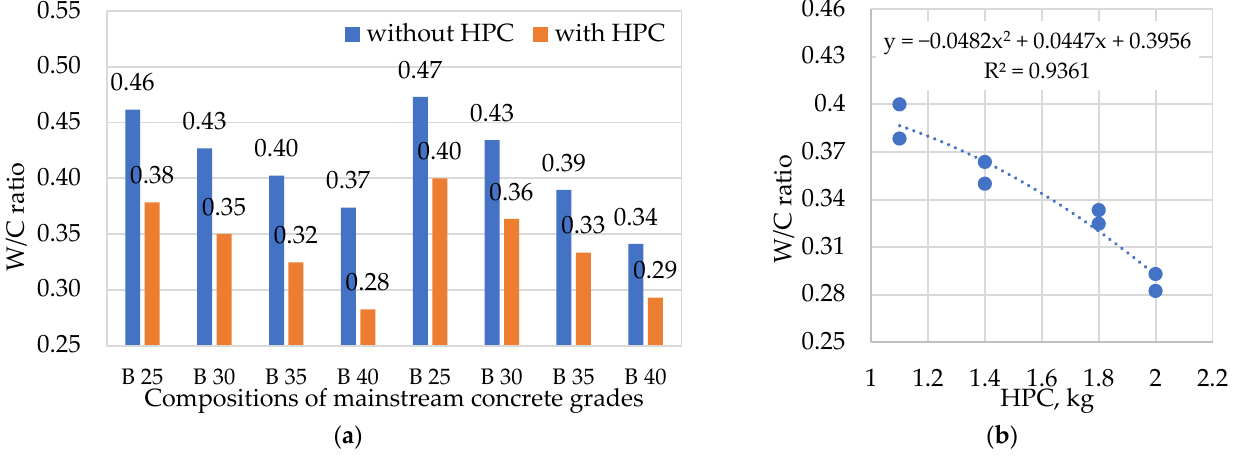
Figure 3. Effect of HPC on W/C ratio: ( a ) dependence of W/C on HPC; ( b ) dependence function.